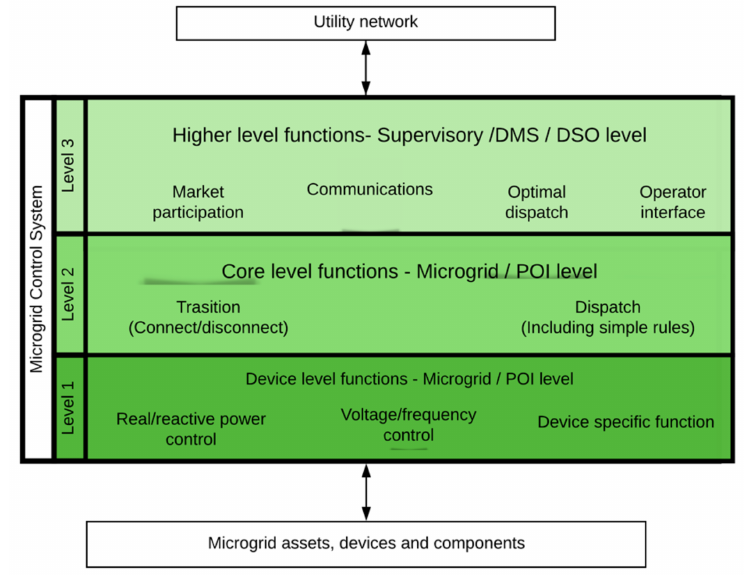
Figure 1. Microgrid control system functional